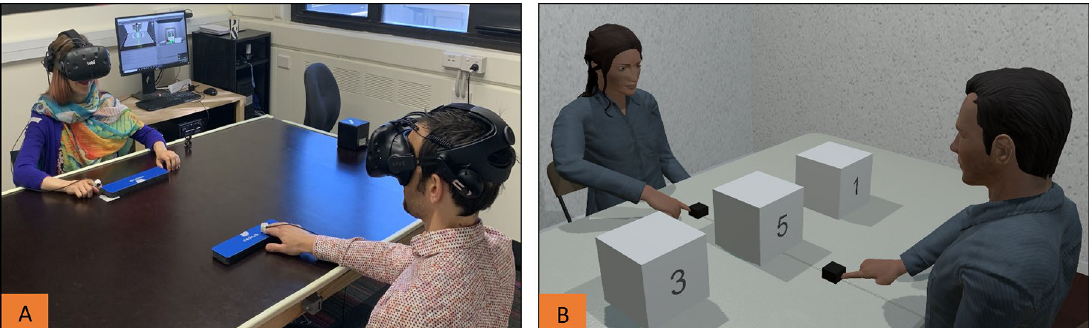
Figure 1. Dyads interacting in the ( A ) physical and ( B ) virtual laboratory. Note. Models photographed in 1A were not research participants from this study and provided written and informed consent for their photos to be used